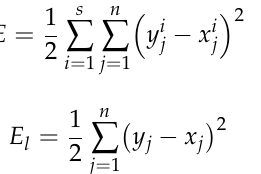
Fusion images Figure 4. CNN-based image fusion framework.